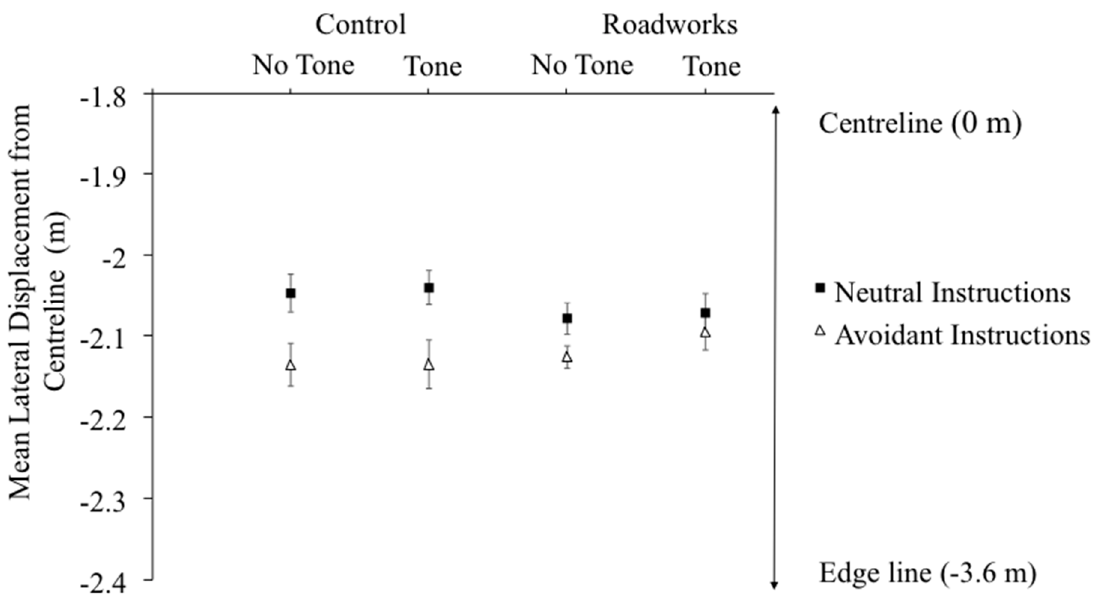
Figure 1. Mean lateral displacement from the centreline (m) across the experimental conditions: instructions that were neutral or avoidant, secondary task (tone counting was present or absent), and driving difficulty (with or without roadworks).